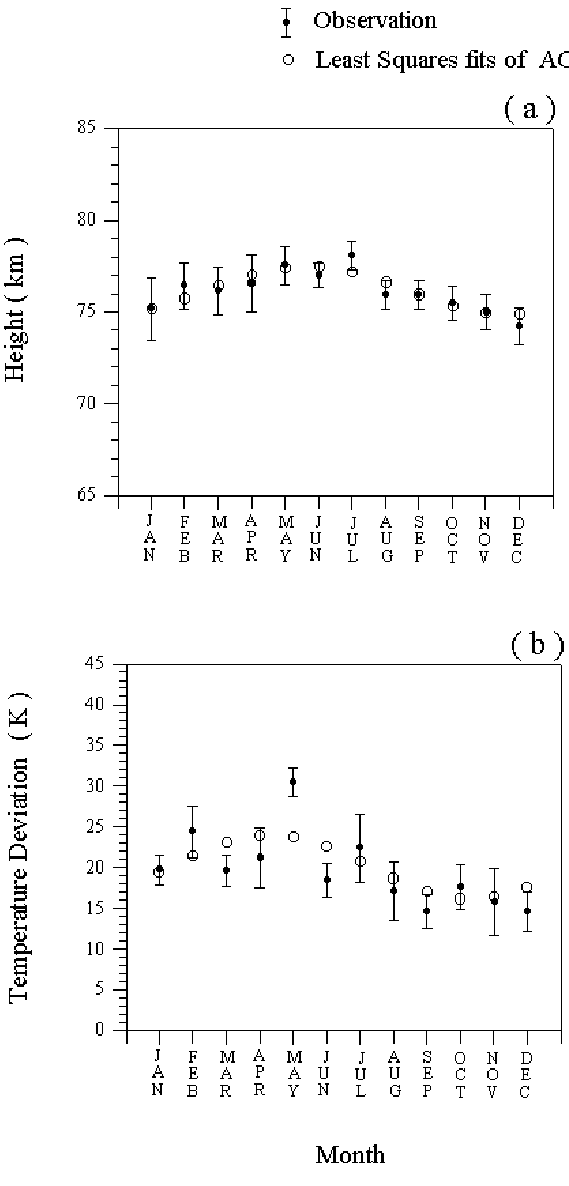
Fig. 4. Monthly variations of (a) peak height and (b) magnitude of the mesospheric temperature